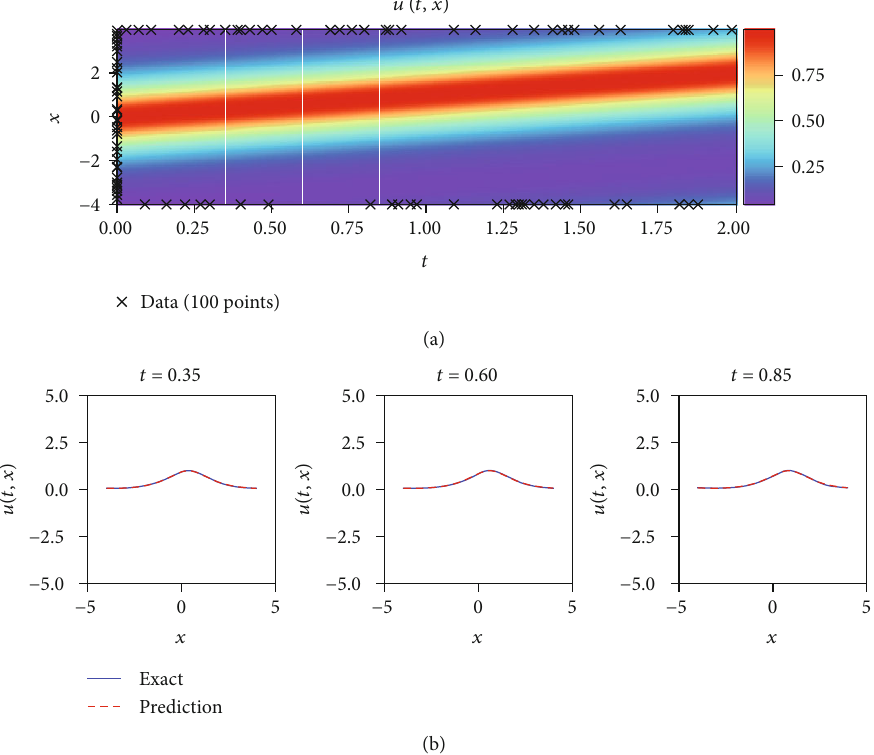
Figure 7: mkdv equation. (a) Predicted solution u ð t , x Þ . (b) Predicted solution and exact solution at t = 0 : 35, 0 : 60, 0 : 85 were depicted by the white vertical lines in (a). The red dashed line is predicted solution, and the blue line is exact solution of u ð x , t Þ